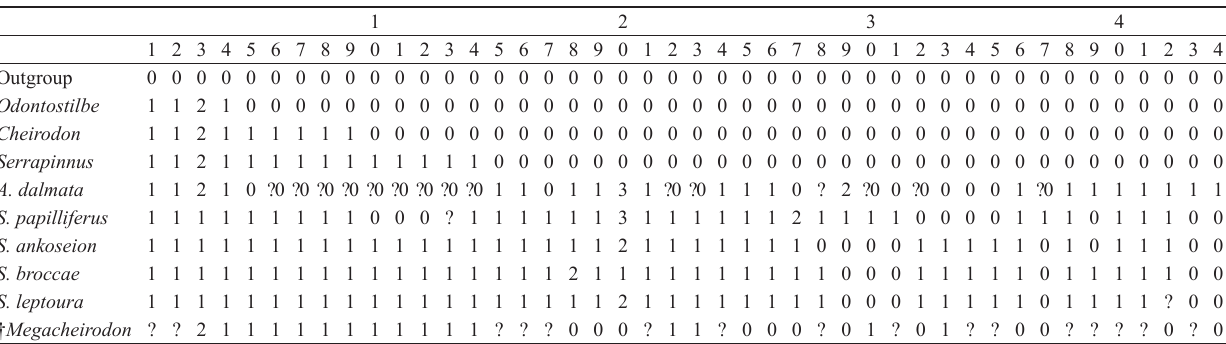
Table 2. Character state matrix for ten Cheirodontinae taxa and 44 characters. Characters 1-35 are numbered according to Weitzman & Malabarba (1999). Characters 36-44 are